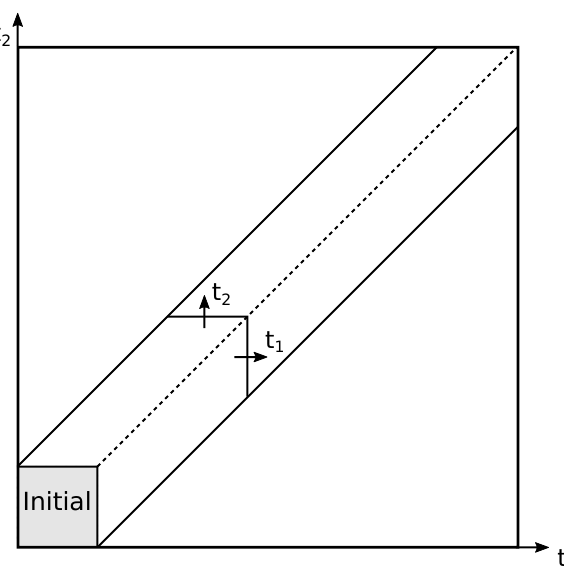
Figure 14 . Geometry of the ( t 1 , t 2 ) plane. The initial Green functions are placed inside the gray